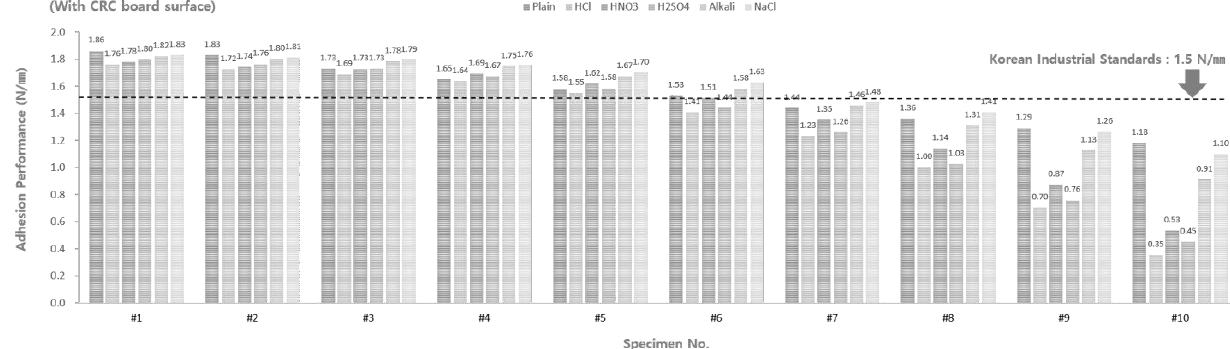
Figure 13. Adhesion performance test result (Crc board surface).